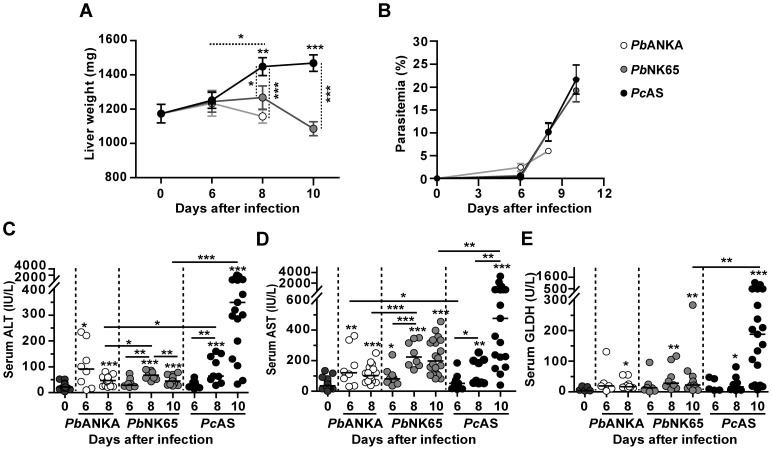
Liver pathology is more severe in PcAS-infected mice than in P. berghei-infected mice.C57BL/6J mice were infected with PbANKA, PbNK65 or PcAS and sacrificed at different time points after infection. PbANKA-infected mice die around day 8, thus no data are available on day 10. (A) Weights of perfused livers. Means are indicated ± SEM (n = 8–21 for each condition). (B) Peripheral parasitemia levels. Means are indicated ± SEM (n = 8–21 for each group). (C–E) Serum levels of ALT (panel C), AST (panel D) and GLDH (panel E) levels. Data are pooled from two separate experiments with similar results. Each dot represents the results from an individual mouse. Small horizontal stripes between individual data points represent group medians and horizontal lines with asterisks on top indicate statistical differences between groups. Asterisks above individual data sets indicate statistical differences with the uninfected control group as follows: * p<0.05, ** p<0.01 and *** p<0.001.